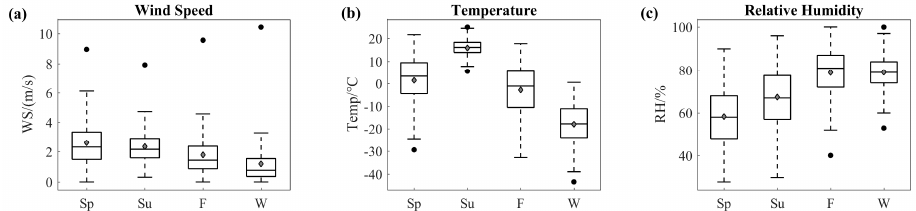
Figure 2. Seasonal variations of ( a ) wind speed ( b ) temperature ( c ) relative humidity (Sp — spring; Su — summer; F — fall; W — winter). The central box represents values from lower to upper quartile (25th to 75th percentile). The vertical line extends from the 10th percentile to the 90th percentile. The middle solid line represents the median. The gray diamond represents the arithmetic average. Maximal and minimal outliers are plotted as black dots.